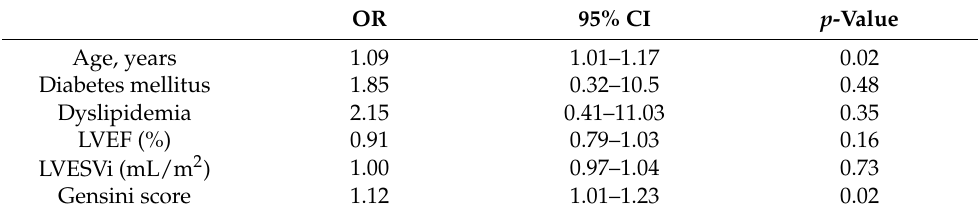
Table 3. Multivariate logistic regression analysis for